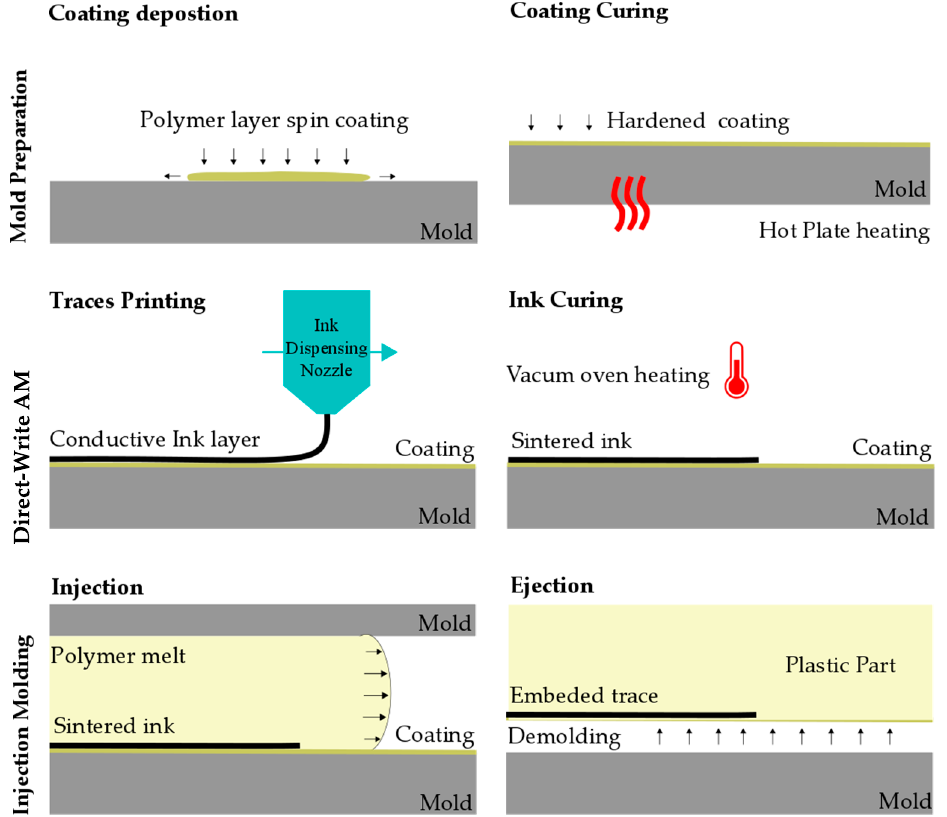
Figure 1. Steps of the process chain developed to manufacture molded interconnect devices.